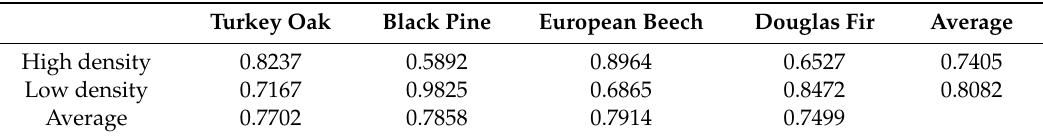
Table 2. Mean of absolute beta waves for species and density.